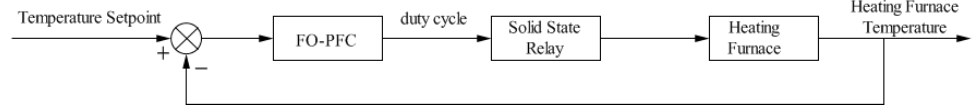
Figure 2. The block diagram of control process.